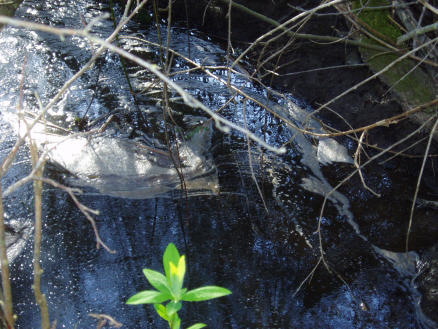
Documentation of Effluents Entering the Sidearm of the Creek, as Recorded by Seventh-Grade Students